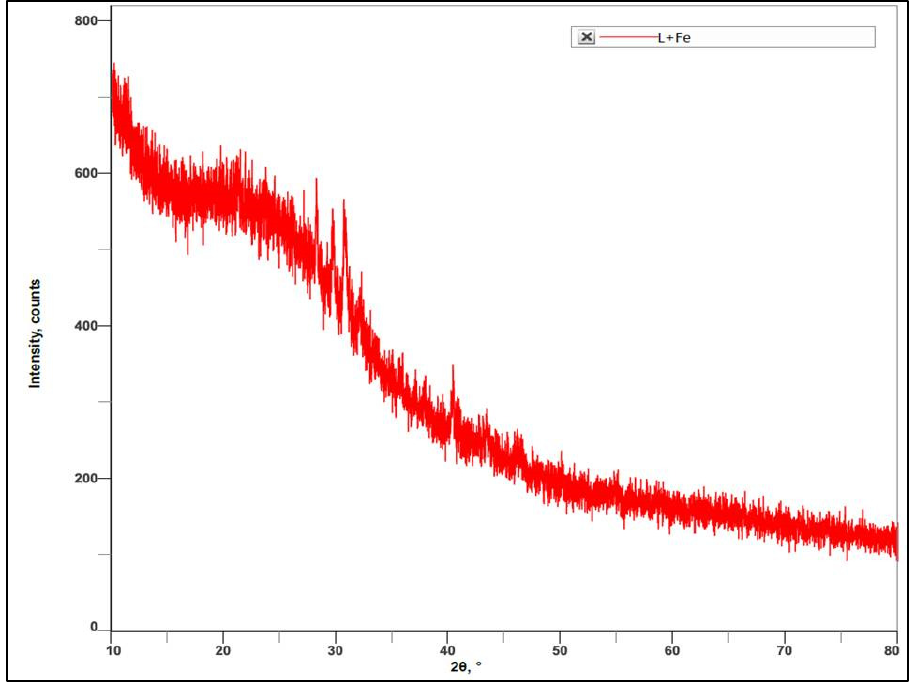
Figure 8. XRD analysis of V. leucoxylon FeNPs.